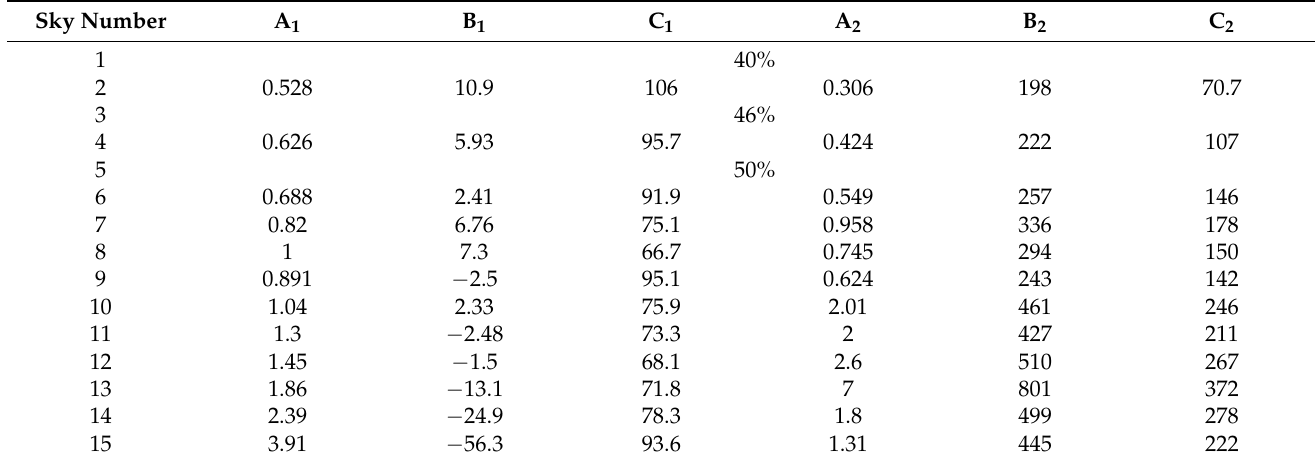
Table 1. Coefficients of A 1 , B 1 , C 1 , A 2 , B 2 and C 2